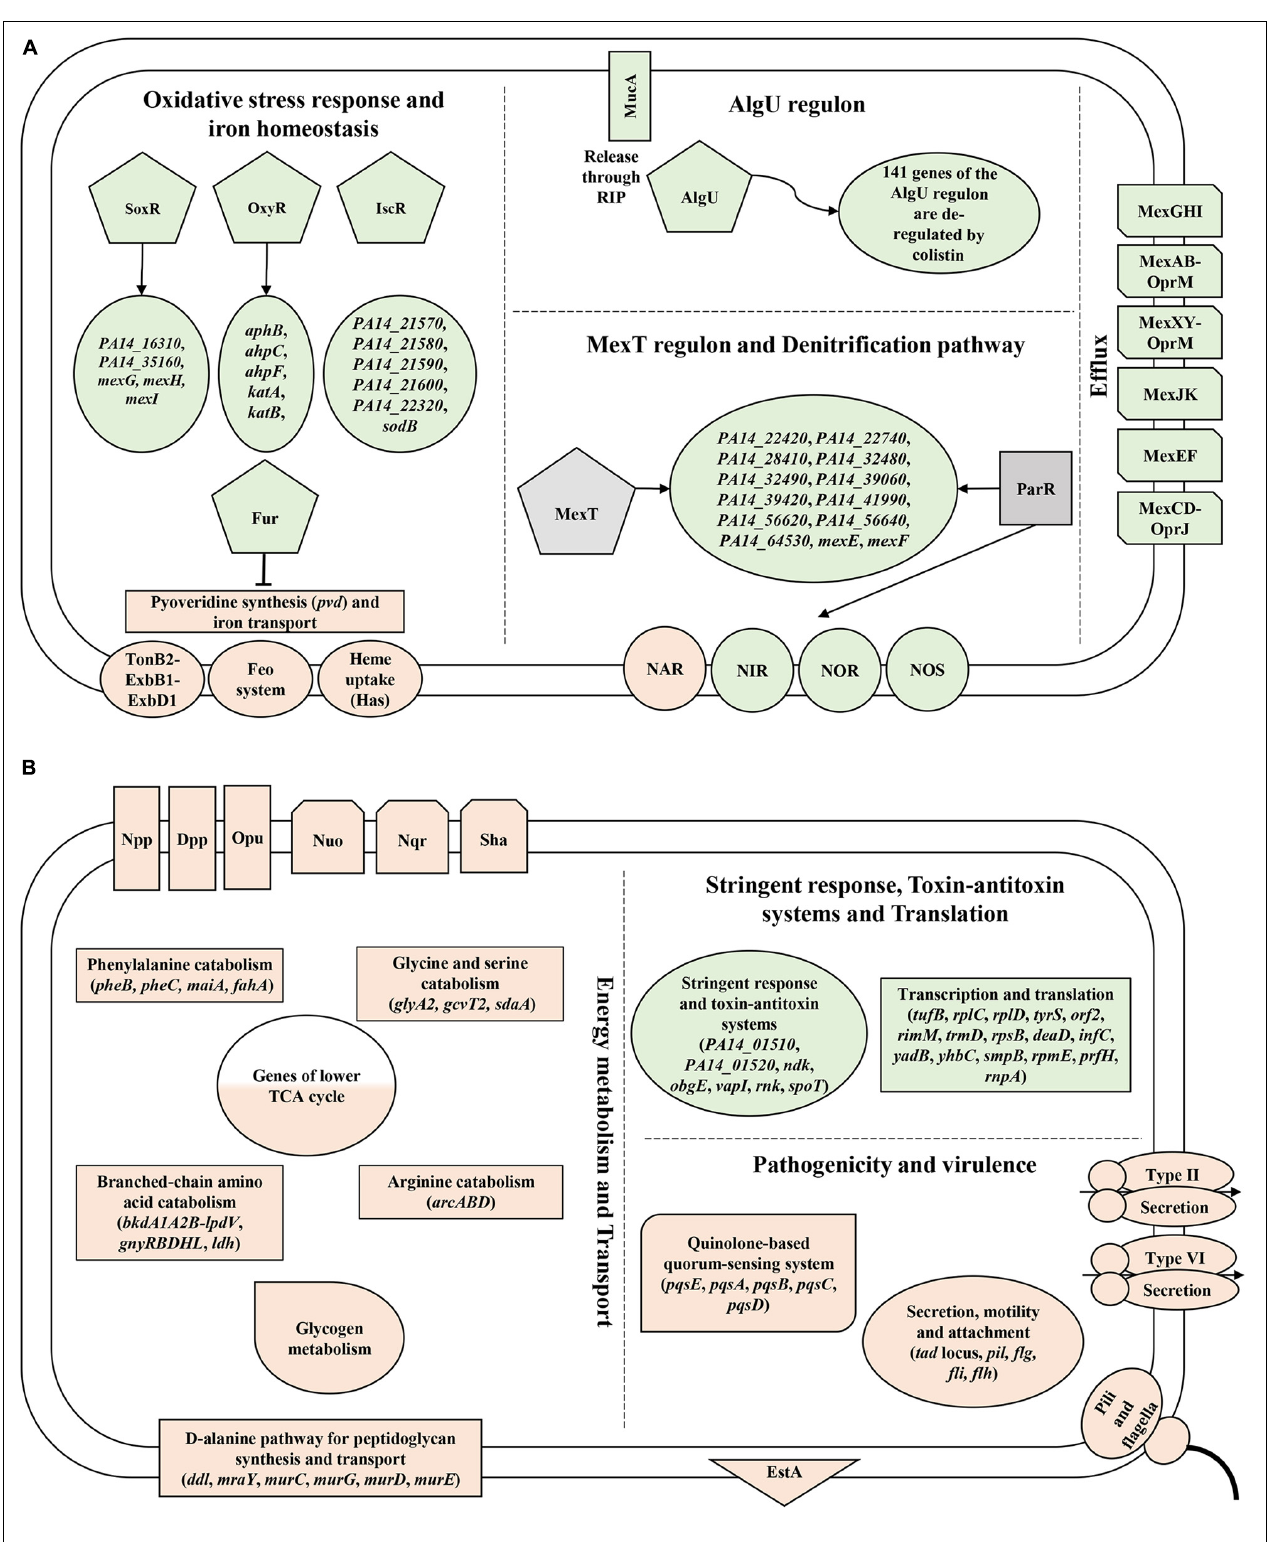
FIGURE 5 | Depiction of novel functions/pathways revealed in this study that are de-regulated upon (A) colistin and (B) tobramycin treatment. Major genes/pathways that are down-regulated and up-regulated based on the RNA-seq and/or Ribo-seq data are highlighted in rose and green, respectively. Positive- and negative regulation of gene expression is denoted by arrows and blocked lines, respectively. RIP - regulated intramembrane proteolysis.